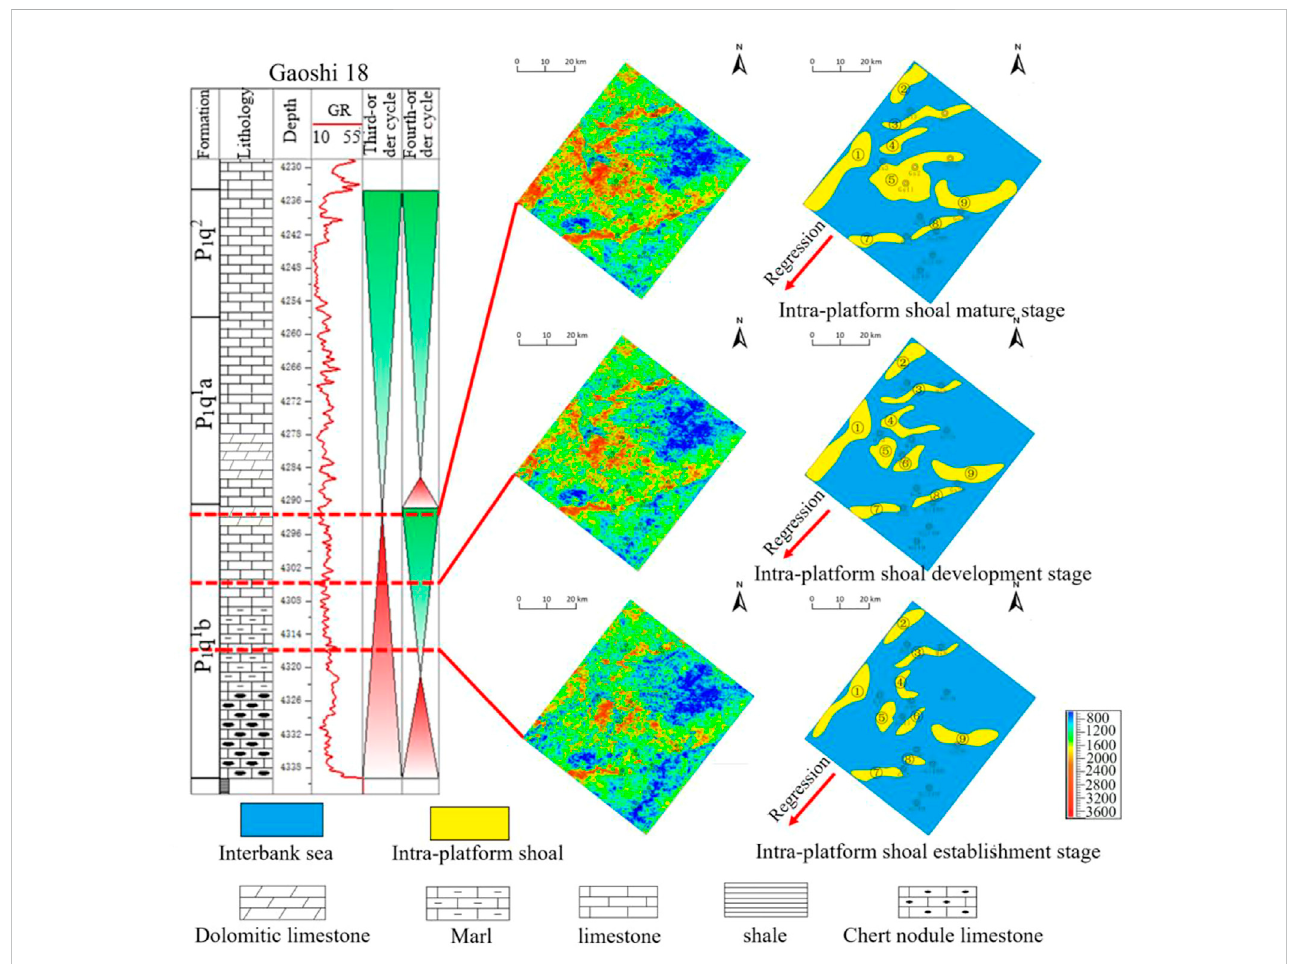
Typical root mean square amplitude attribute slice and corresponding sedimentary microfacies interpretation in